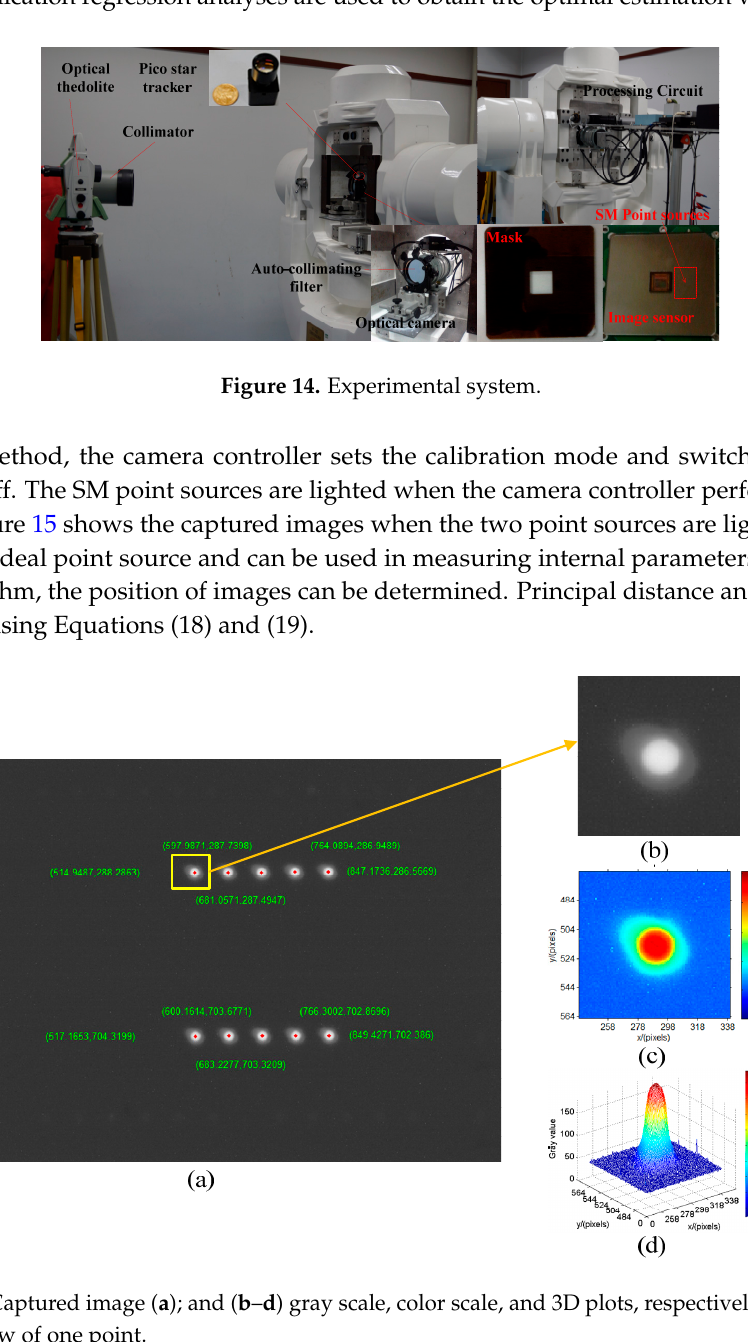
Figure 15. Captured image ( a ); and ( b – d ) gray scale, color scale, and 3D plots, respectively, of the same detailed view of one point.